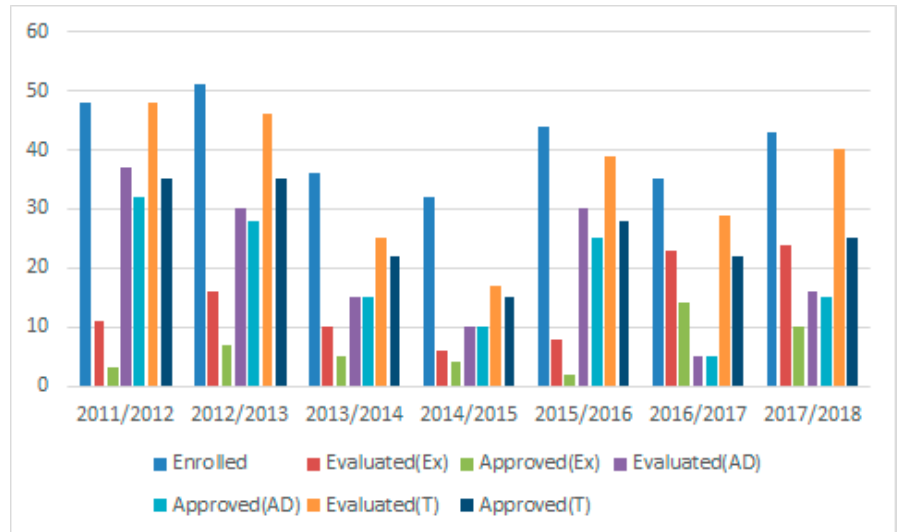
Figure 8. Pass rates distribution (AD, Ex, T): Biomedical.